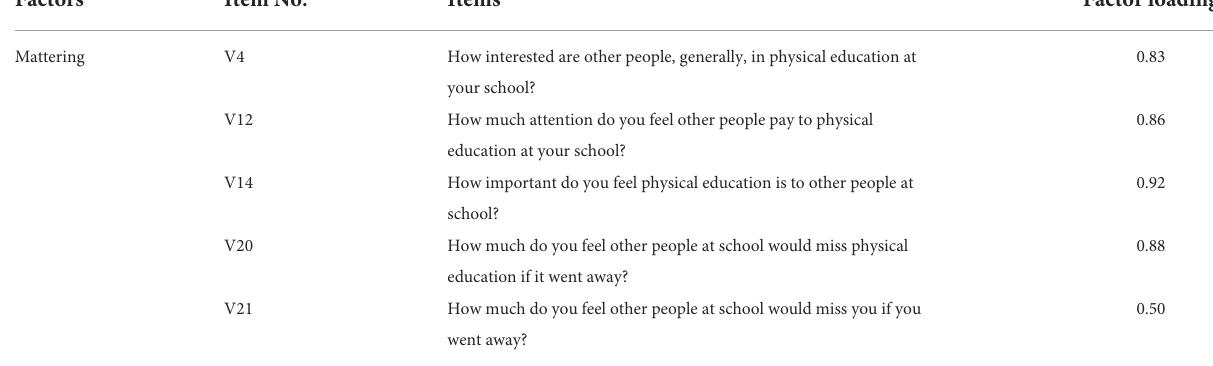
TABLE 3 The modified PMQ-PEC and factor loadings of the one-factor CFA using sample